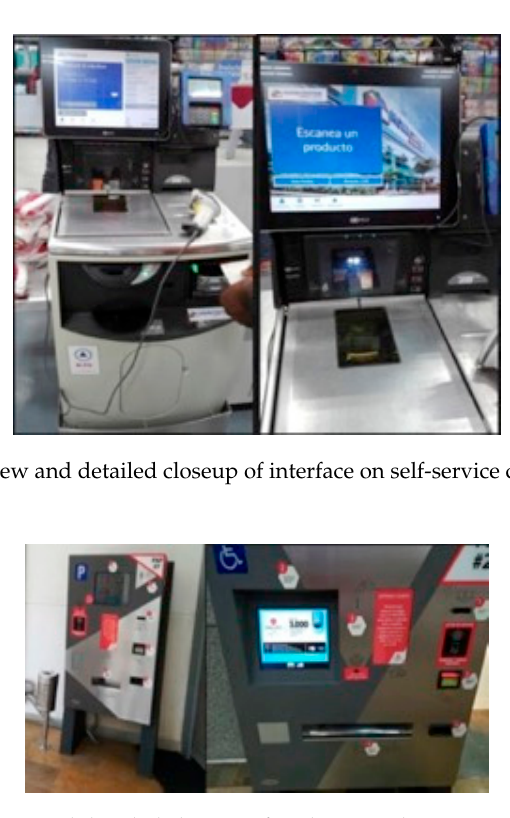
Figure 9. General overview and detailed closeup of parking machine in commercial shopping center in Cali.